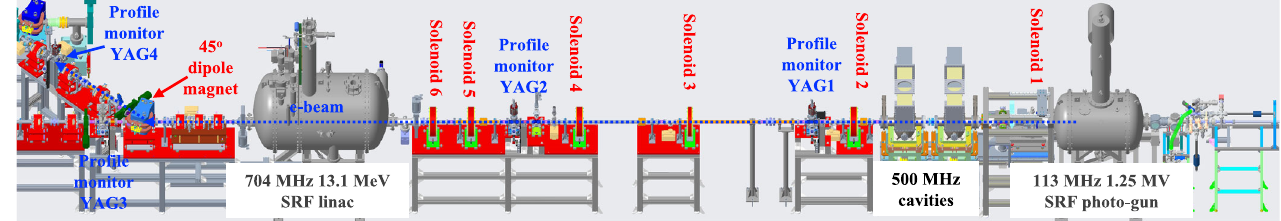
FIG. 13. Layout of the CeC accelerator (right to left): the SRF electron gun, two room-temperature rf cavities, the LEBT line equipped with six solenoids and two profile monitors, followed by the 13.1 MeV SRF linac and a 45º bending magnet beam line (with three quadrupoles and a beam profile monitor).